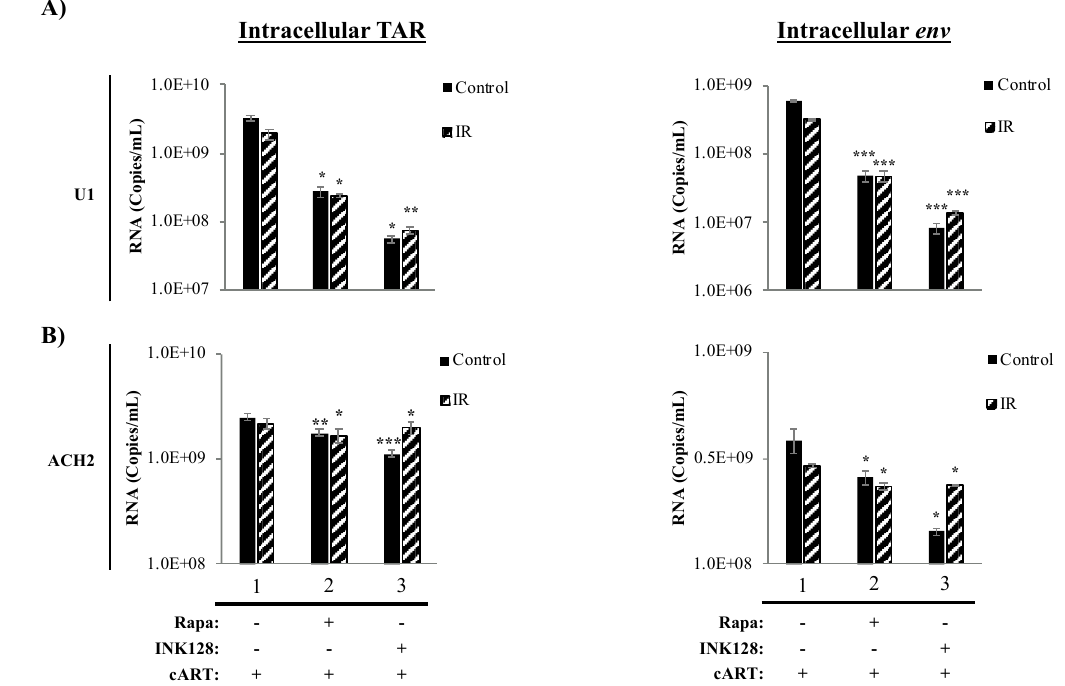
Figure 4 . AI drugs mediate viral RNA levels in infected myeloid and T-cells. AI drugs (mTOR inhibitors; Rapa and INK128 at 300 nM) were administered as described in Figure 3, and cells were allowed to incubate for 5 days. Rapa is an mTOR complex-1 inhibitor, while INK128 is a more potent mTOR complex-1/2 inhibitor. Intracellular short RNA transcript TAR and env RNA was measured via RT-qPCR for U1 ( A ) and ACH2 ( B ) cells.